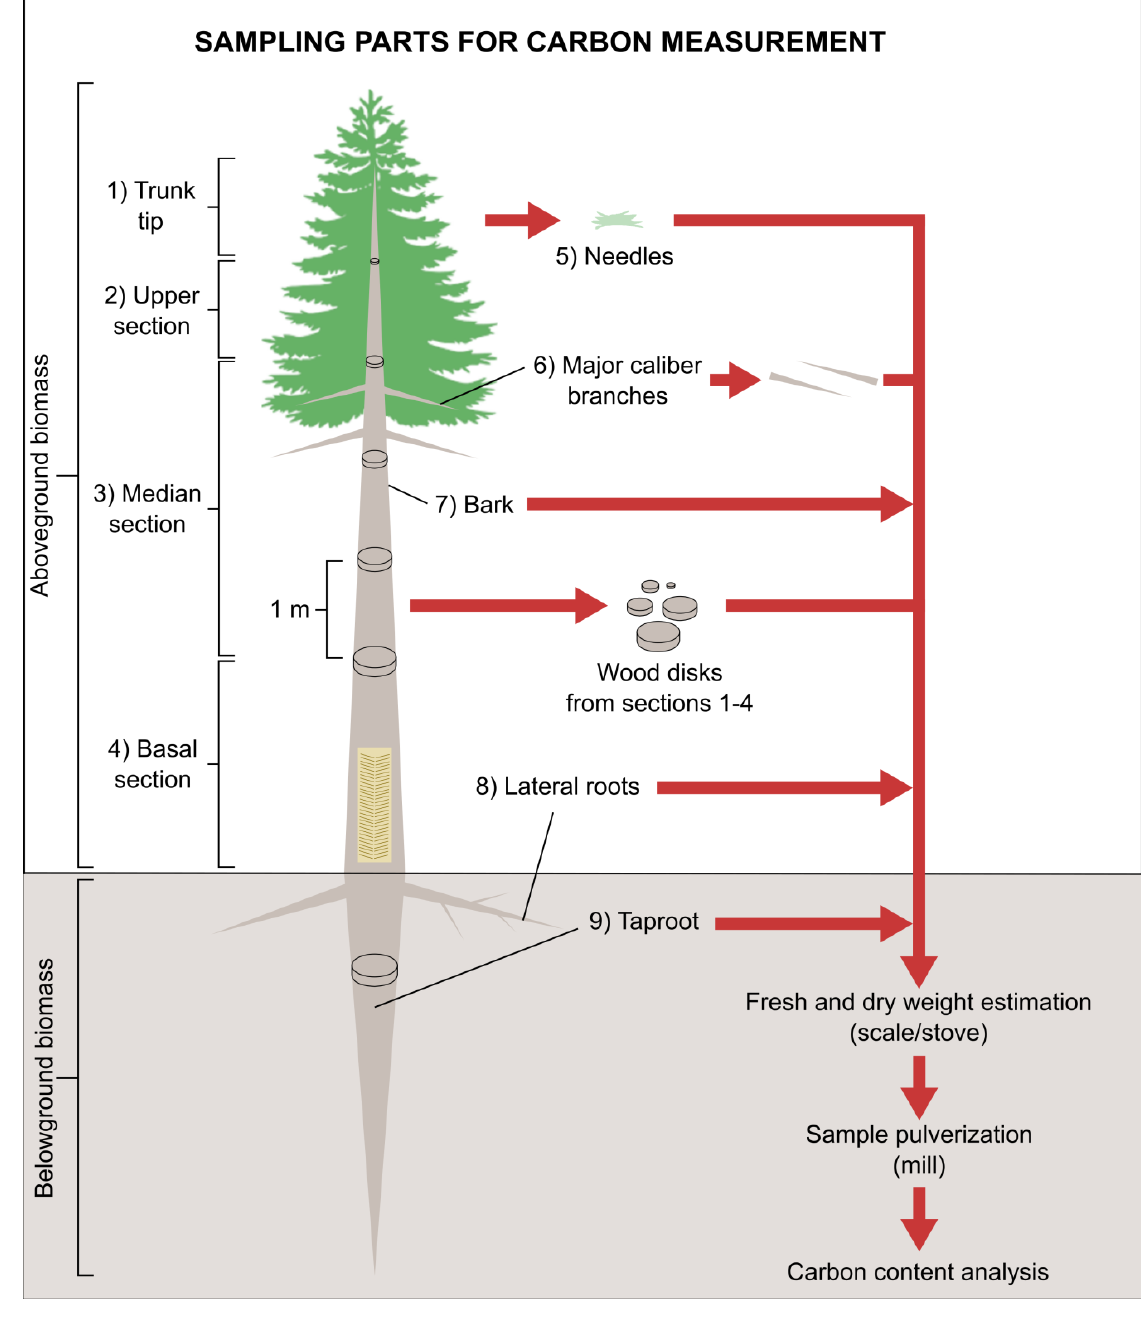
Figure 1. Schematic representation of plant biomass sample collection for carbon stock evaluation in slash pine trees. Five samples of every plant section indicated in the drawing were collected for every analyzed pine tree.